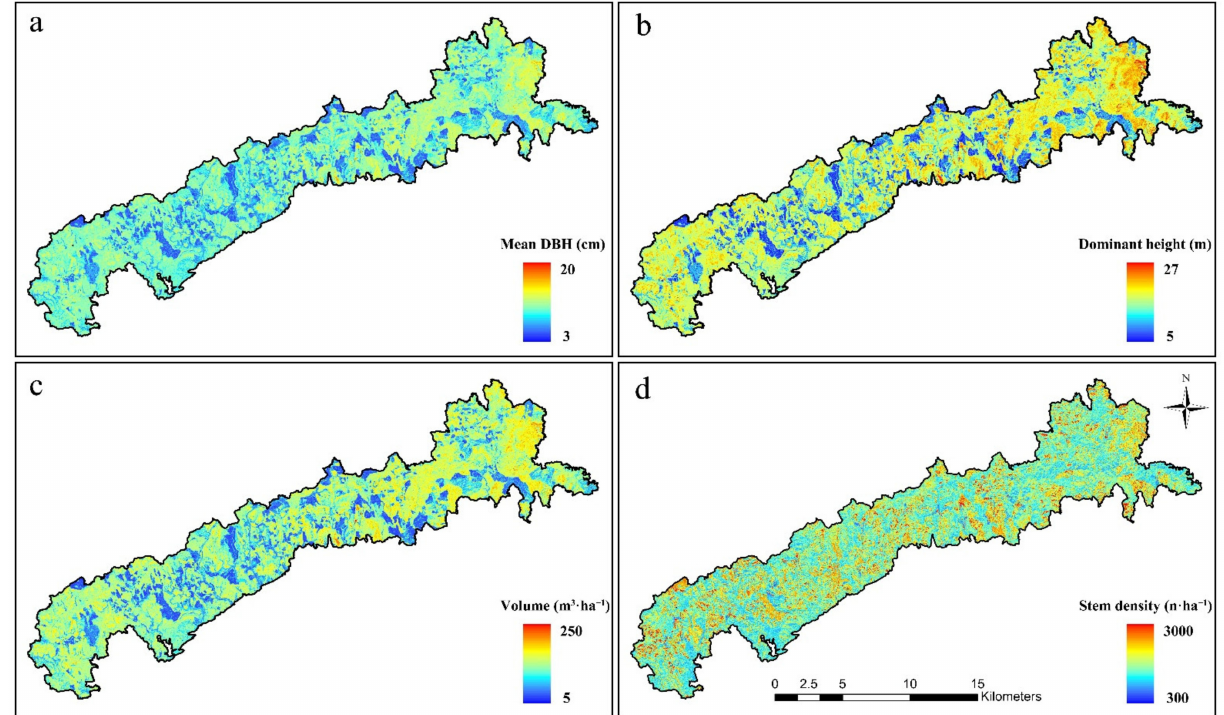
Figure 7. The mapping of forest structural parameter mapping results using the two-stage extrapola- tion approach that was combined with field plots, UAV-LiDAR, and GF-6 imagery. Subfigures ( a – d ) represented the mapping of mean DBH, dominant height, volume and stem density,